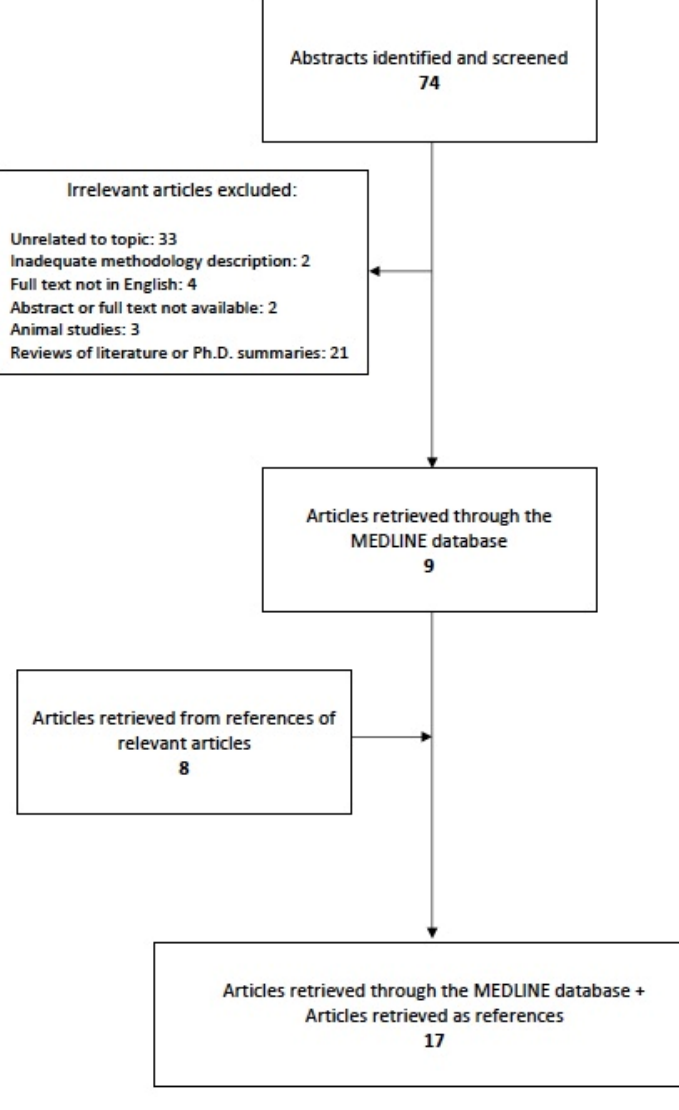
Figure 1. Stages of the search strategy.